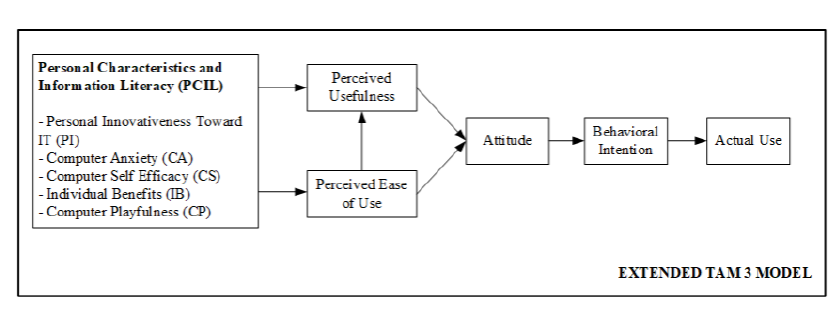
Figure 2: Extended TAM 3 Model; Source: